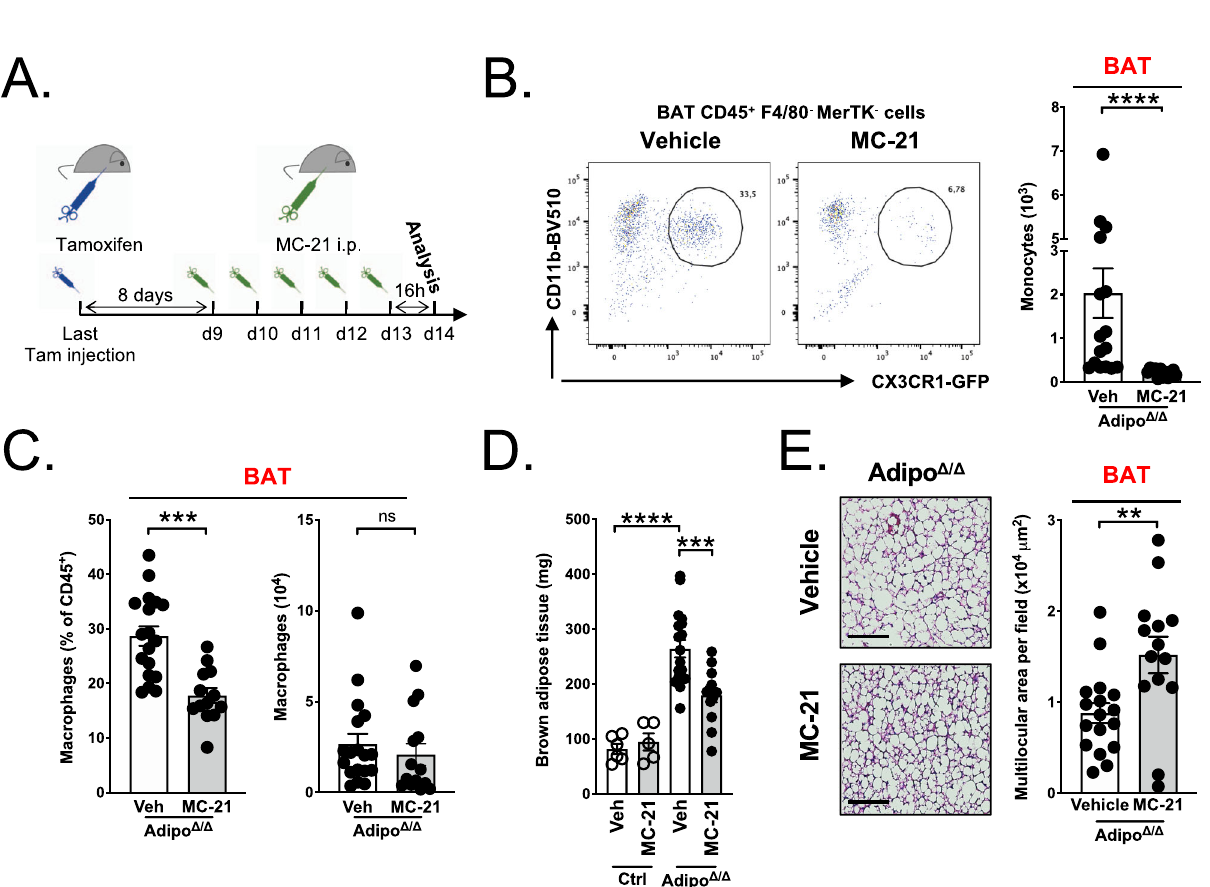
Fig. 4 Monocyte depletion prevents the expansion of lipolysis-de fi cient BAT. A Schematic representation of the experimental procedure used for MC- 21-mediated monocyte depletion. B Representative dot plots (left) and quanti fi cation (right) of BAT monocytes in MC-21 ( n = 12) or vehicle-treated ( n = 16) Adipo Δ / Δ mice. p < 0.0001. C Frequency and numbers of BAT macrophages in MC-21 ( n = 13) or vehicle-treated ( n = 18) Adipo Δ / Δ mice. p = 0.0001 (left) and p = 0.3189 (right). D Brown adipose tissue weight in MC-21 ( n = 5) or vehicle-treated ( n = 6) control mice, and MC-21 ( n = 14) or vehicle-treated ( n = 18) Adipo Δ / Δ mice. p < 0.0001 (vehicle-treated control and Adipo Δ / Δ mice) and p = 0,0002 (vehicle-treated and MC-21-treated Adipo Δ / Δ mice). E Representative images of H&E-stained BAT and quanti fi cation of multilocular areas in MC-21 ( n = 14) or vehicle-treated ( n = 17) Adipo Δ / Δ mice. Scale bar = 100 μ m. p = 0.0053. Data were derived from three pooled independent experiments. All data are represented in means ± SEM. Two-tailed Mann − Whitney tests were used to determine statistical signi fi cance. ns p > 0.05; * p < 0.05; ** p < 0,01; *** p < 0.001. Source data are provided as a Source Data fi required a cell-to-cell contact, or alternatively was mediated by monocyte interaction with fi broblasts induced changes in their soluble mediators. In a transwell experiment, allowing for phy- morphology. Therefore, we investigated whether these morpho- sical separation between fi broblasts and monocytes, we observed logical changes were paralleled by modulations of fi broblast that fi broblast spreading occurred even in the absence of direct mechanical properties. Using a traction force microscopy contact with monocytes (Fig. 5A, B). These results indicated that approach, we observed that fi broblasts co-cultured with